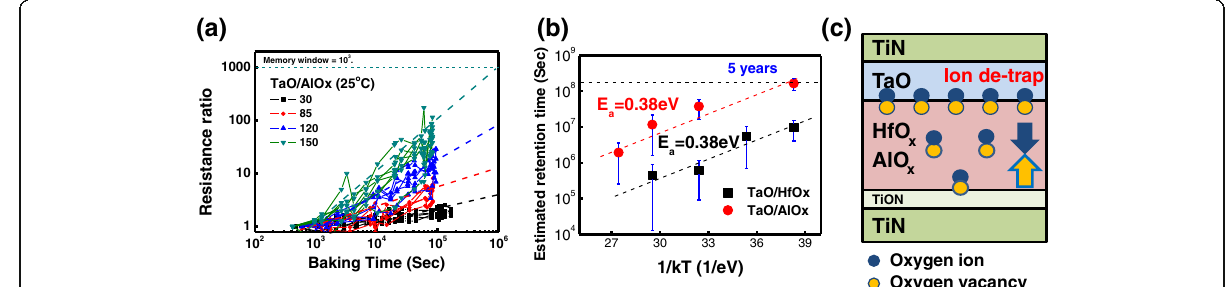
Fig. 4 a Resistance variation ratio versus baking time for different temperatures in TaO/AlO x devices. The average initial resistance was 179 MOhm with a reading voltage of 2 V, and the LRS resistance degradation rate was calculated by the linear fitting method in log( R ratio ) – log(T) scale. b Estimated retention time (1000×) versus 1/kT plot. Each point contains data from 18 devices taken at a reading voltage of 2 V. The extracted activation energies were 0.38 eV in both the TaO/AlO x and TaO/HfO x devices. c Retention schematic diagram of different oxygen diffusion barriers in HfO x or AlO x with a TaO capping